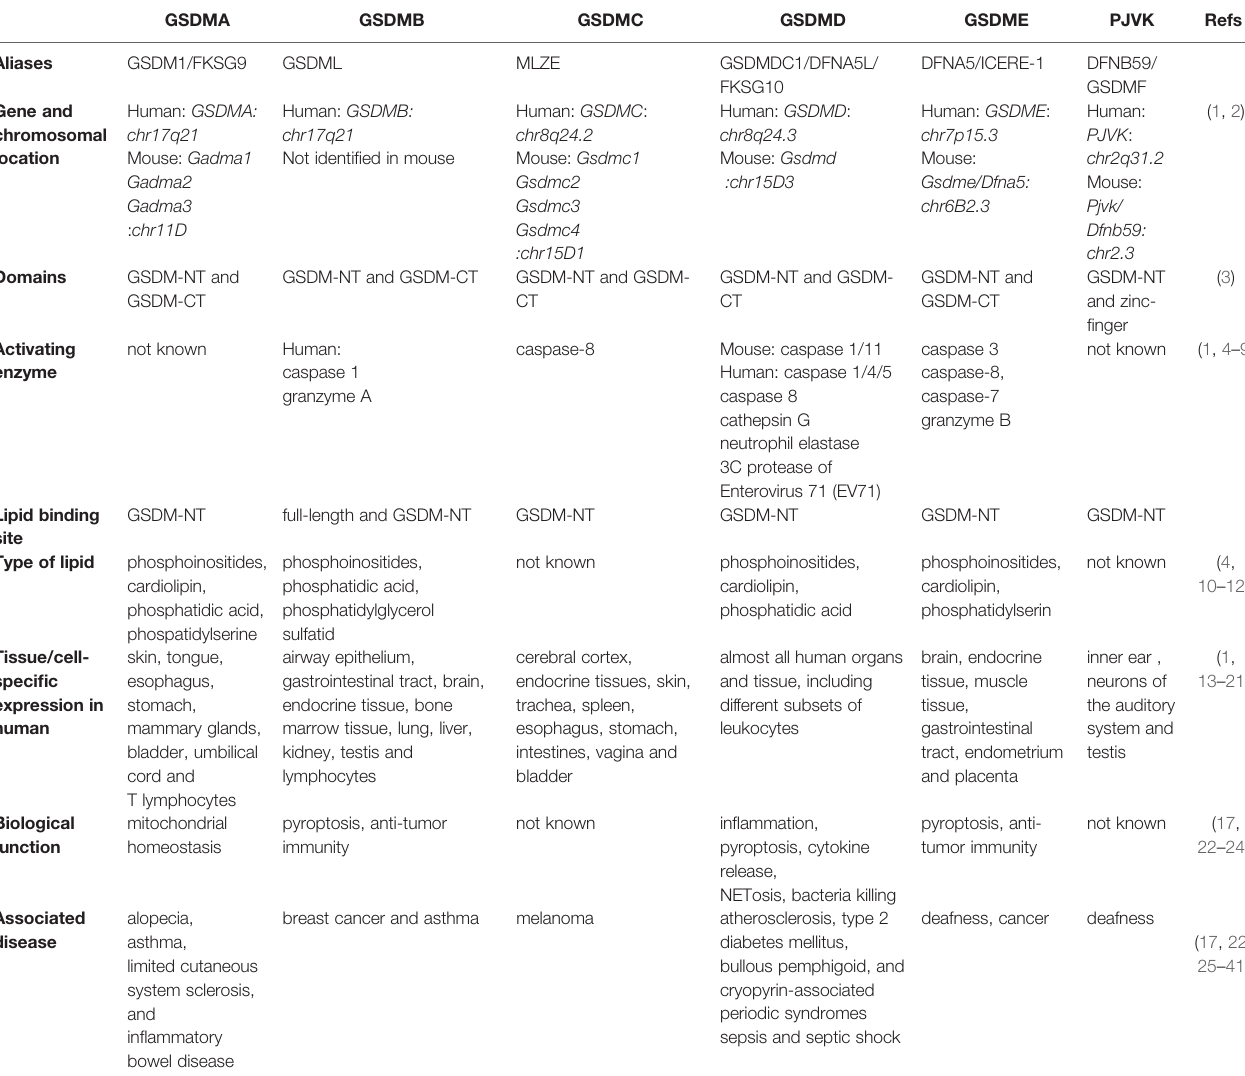
TABLE 1 | GSDM family members, structures, functions, and disease